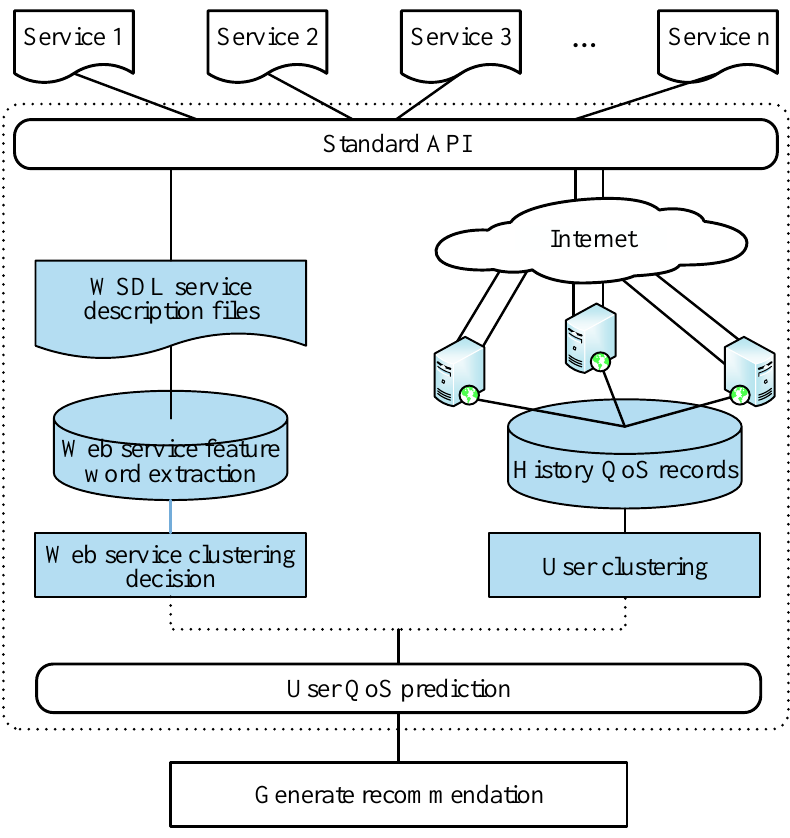
Figure 2. Recommendation model based on user and service clustering (RMUSC) modeling architecture.